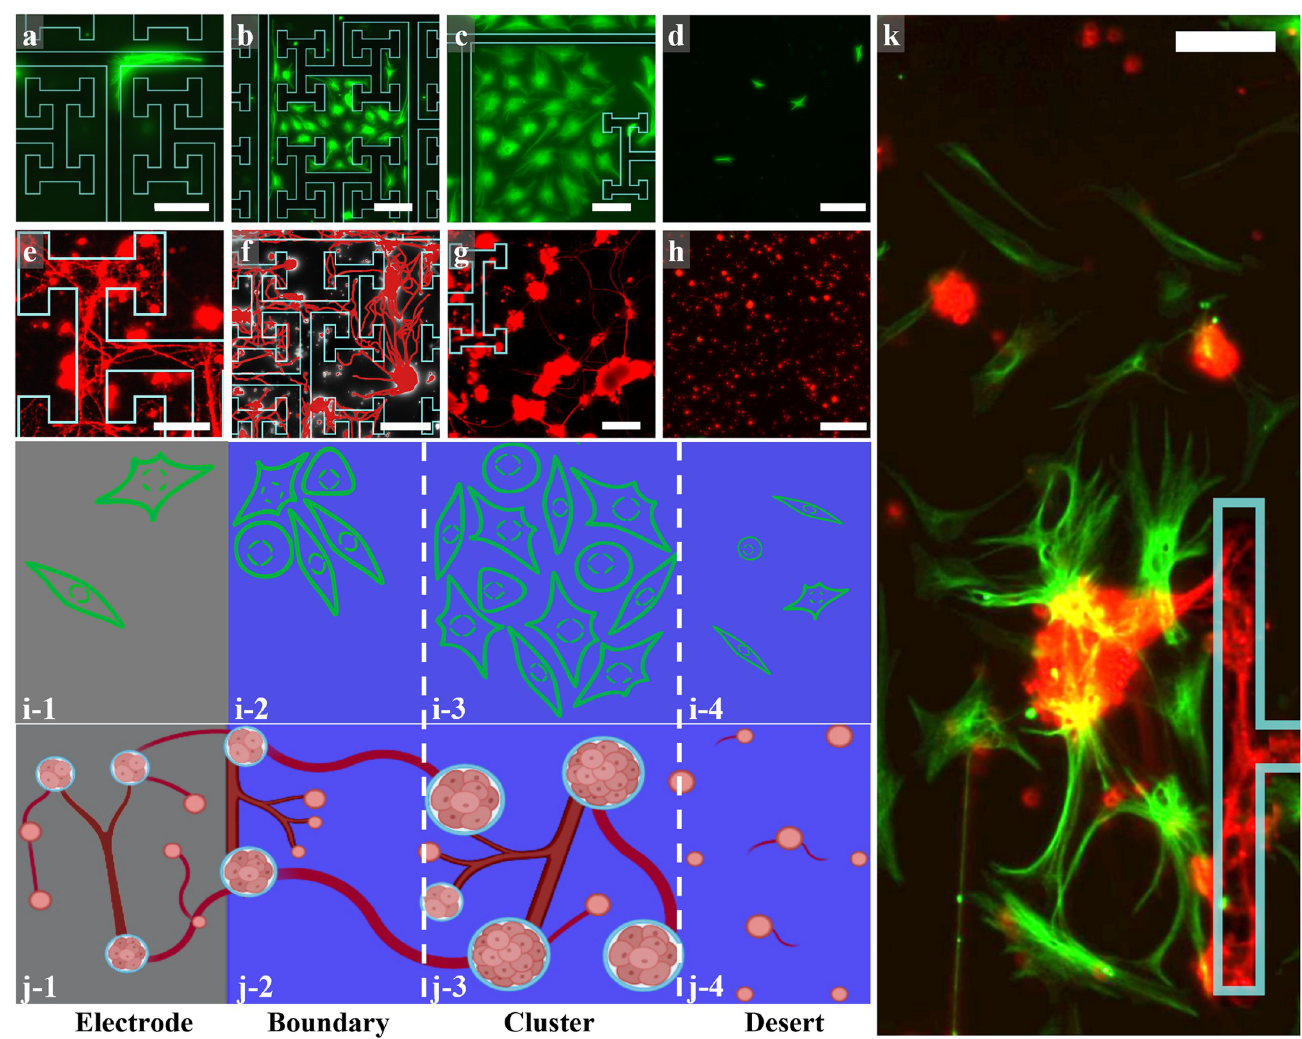
Fig 3. Examples of fluorescence images of retinal cells interacting with the fractal electrodes at 17 DIV (green = GFAP labelled glia; red = β -tubulin III labelled neurons). (a) The rare occurrence of glia following the 90˚ turn of a 2–6 electrode branch. (b) Glial coverage in the gap of a 2–6 electrode. (c) Glial coverage in the gap of a 1.1–4 electrode close to its branches. (d) Individual glia in a desert region away from the branches of a 1.1–4 electrode. (e) Neurons and their processes on a 2–6 electrode’s branches. (f) Neuron clusters and processes in a boundary region interacting with the neurons on the nearby branches of a 2–6 electrode. Neuronal processes were semi-automatically traced using the Fiji simple neurite tracer and were false-colored. (g) Neuron clusters and processes forming a cluster neural network in the gaps of a 1.1–4 electrode. (h) individual neurons in a desert region of a 1.1–4 electrode far from the branches. (i) and (j) Schematic of the glial and neural network regions. (i-1) and (j-1) show the electrode with few glial cells and multiple processes connecting individual neurons and small to medium-sized clusters. (i-2) and (j-2) show the ‘boundary’ region featuring small to medium glial coverage regions and clusters connecting to each other and to neurons on the electrodes using multiple processes. (i-3) and (j-3) show the ‘small-world’ region featuring larger glial coverage and clusters with bundles of processes connecting them. (i-4) and (j-4) show the ‘desert’ region furthest from electrodes featuring very few glial cells, mostly individual neurons and very few processes. (k) Merged fluorescence image of glia and neurons on a 2–4 electrode showing all the different regions. Scale bars on (a), (b), (c), (f), and (g) are 100 μ m, on (d) and (h) are 200 μ m, and on (e) and (k) are 50 μ m. The electrode edges are highlighted in cyan in (a), (b), (c), (e), (f), (g) and (k). Schematic panels were created in